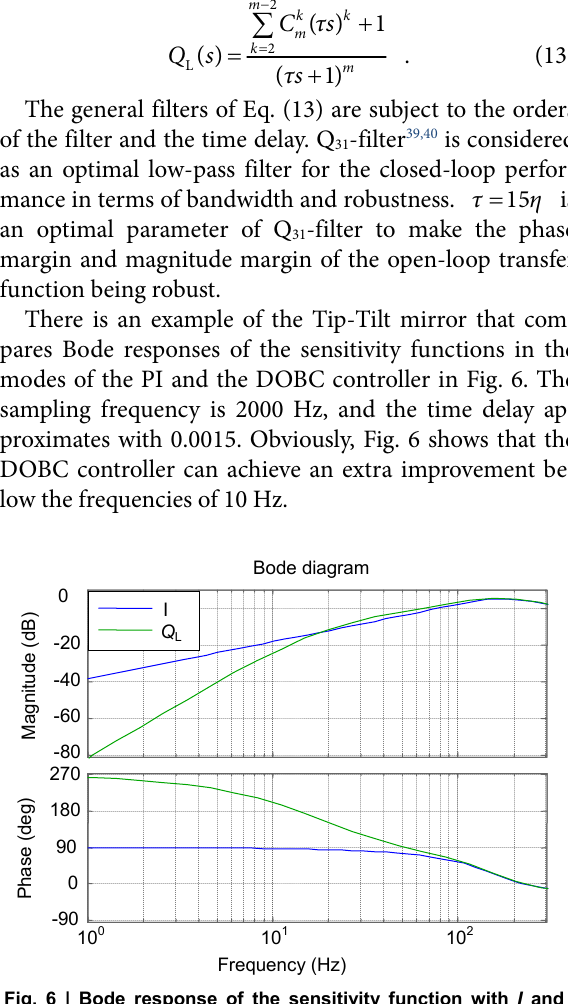
Fig. 6 | Bode response of the sensitivity function with I and Q L ( s ).